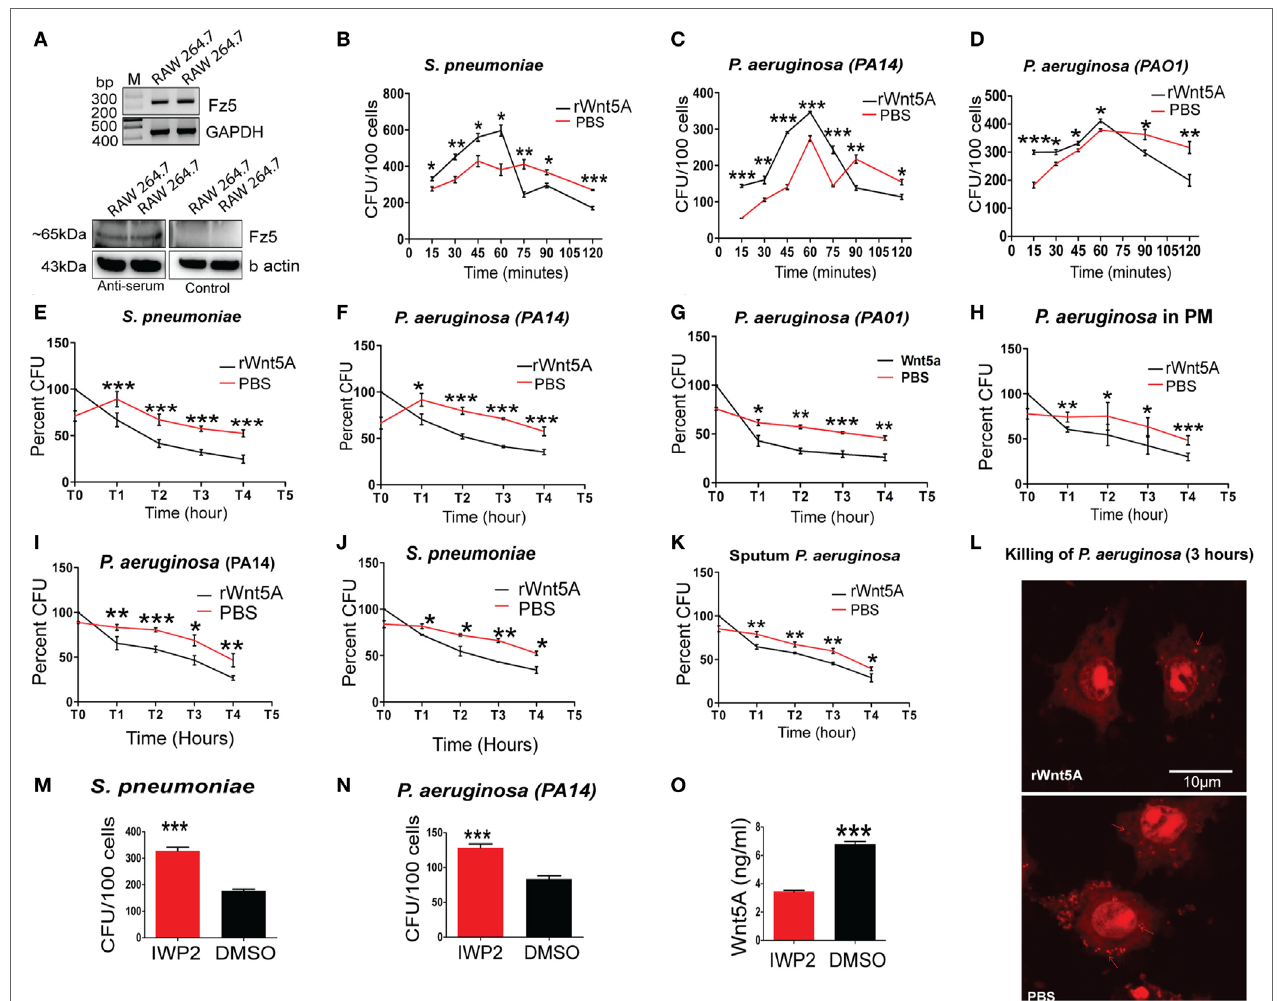
FigUre 3 | Wnt5A signaling promotes internalization and killing of pathogenic bacteria. (a) Reverse transcription PCR analysis (upper panel) and immunoblot (lower panel) demonstrating Fz5 (putative Wnt5A receptor) expression in RAW 264.7 macrophages using anti-Frizzled-5 antiserum (Immune serum) and pre-immune serum (control). (B–D) Effect of rWnt5A on internalization and total killing of Streptococcus pneumoniae (SP) (B) , Pseudomonas aeruginosa (PA): PA14 (c) , and PA01 (D) as estimated by colony forming unit (CFU) ( n = 3). (e–g) Facilitated intracellular killing of SP (e) , PA14 (F) , and PA01 (g) in RAW 264.7 as estimated by percent CFU recovered at different time points (T1–T4) after 1 h infection (T0) ( n = 3). (h) Wnt5A-mediated killing of PA in mouse peritoneal macrophages ( n = 3). (i,J) Wnt5A-induced intracellular killing of PA14 (i) and SP (J) in J774A.1 at different time points (T1–T4) after 1 h infection (T0) ( n = 3). (K) Similar killing activity of Wnt5A on RAW 264.7 macrophages infected with PA strain isolated from COPD patient sputum ( n = 3). (l) rWnt5A facilitated bacterial killing depicted by confocal microscopy. Red dots indicate propidium iodide stained bacteria 3 h postinfection in RAW 264.7 macrophages pretreated either with rWnt5A or PBS. (M,n) Inhibitor of Wnt production (IWP2)-mediated inhibition (24 h of IWP2 treatment after 1 h infection) of Wnt5A production leading to significant sustenance of SP (M) and PA (n) in RAW 264.7 ( n = 6). (O) ELISA documenting IWP2 mediated reduction in Wnt5A secretion from RAW 264.7 macrophages ( n = 3). Data represented